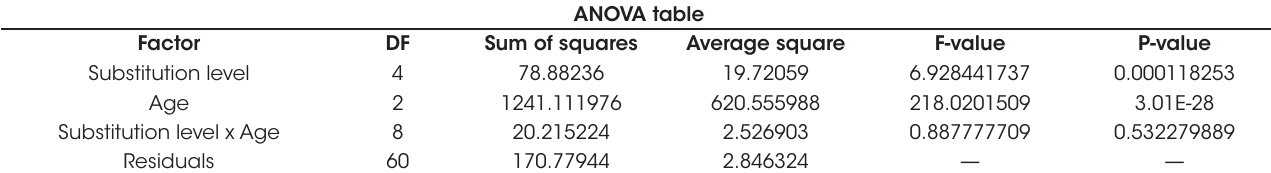
Analysis of variance results – p value – of compressive